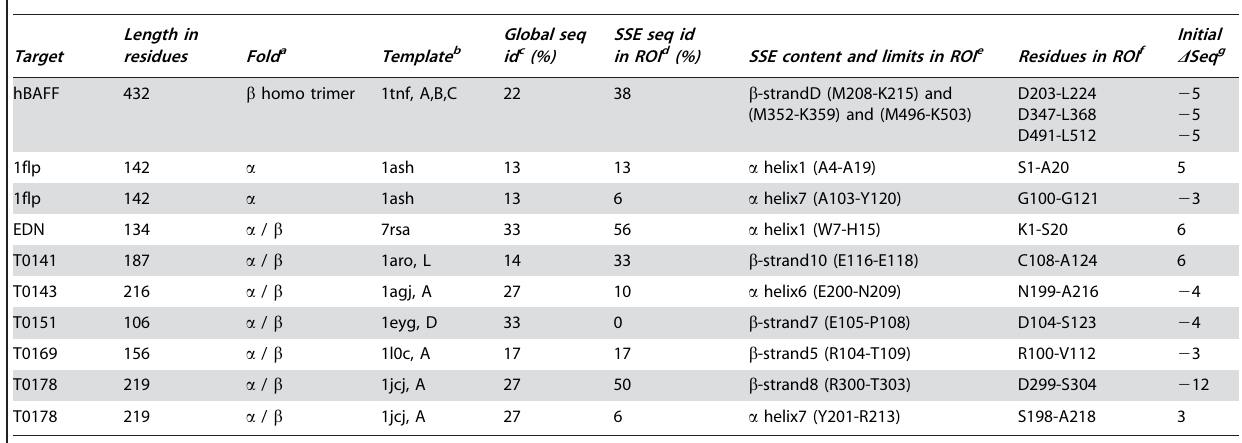
Table 1. List of the test cases.